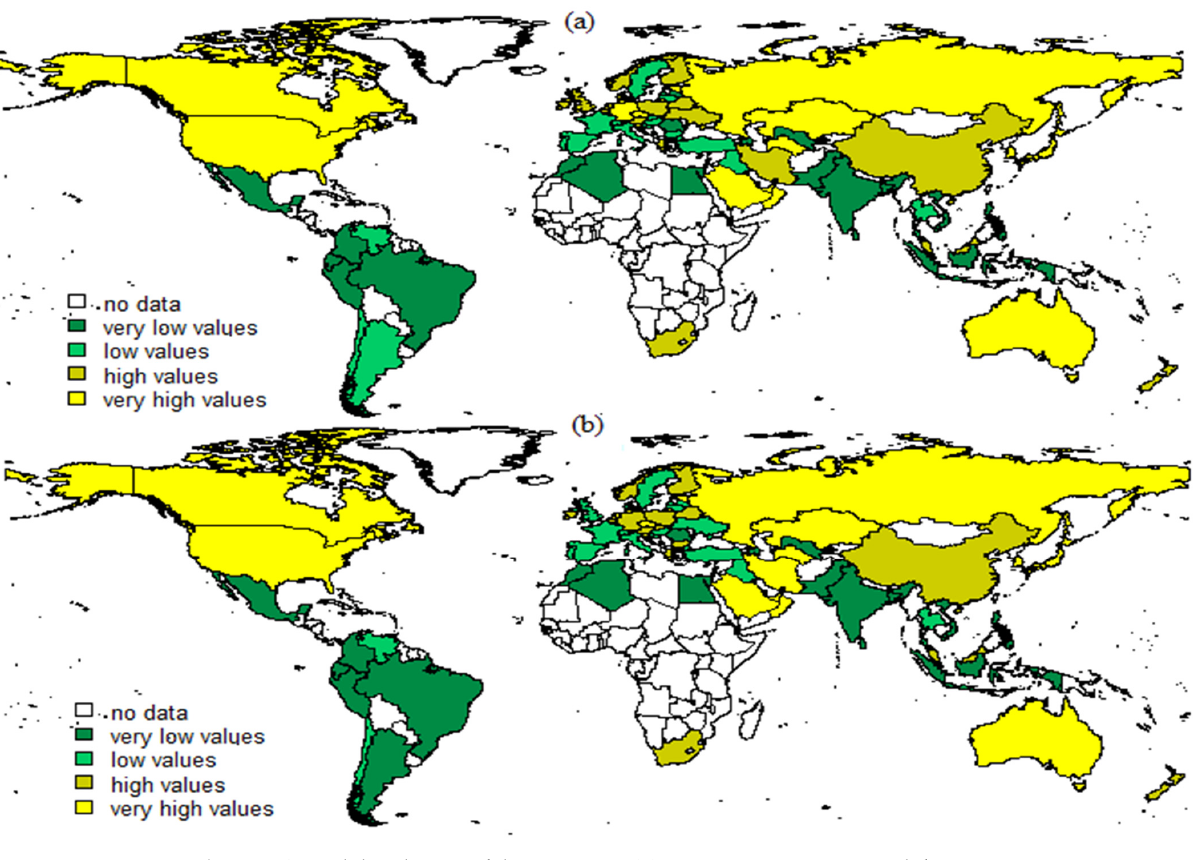
Figure 1. Spatial distribution of the per capita CO 2 emissions in ( a ) 2013 and ( b ) 2019.